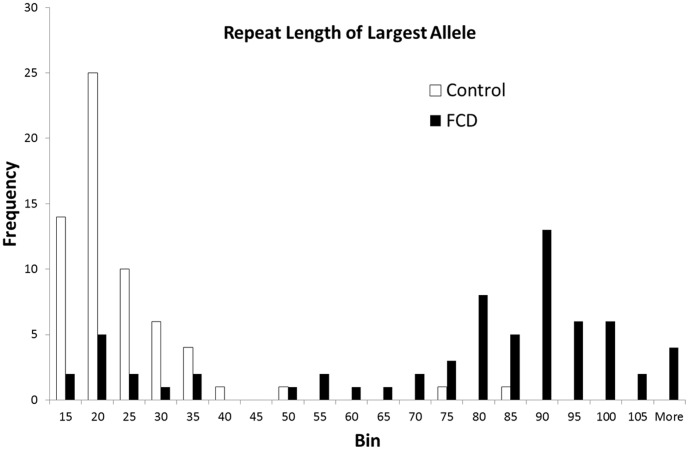
Frequency histogram of the TGC repeat length of the longest allele in all 129 samples.The length of the longest repeat in each sample is shown for both FECD patients (black bars) and normal control subjects (open bars). Note that 3 FECD patients had very long repeat expansions (more than 1500 repeats), as shown in Figure 4.